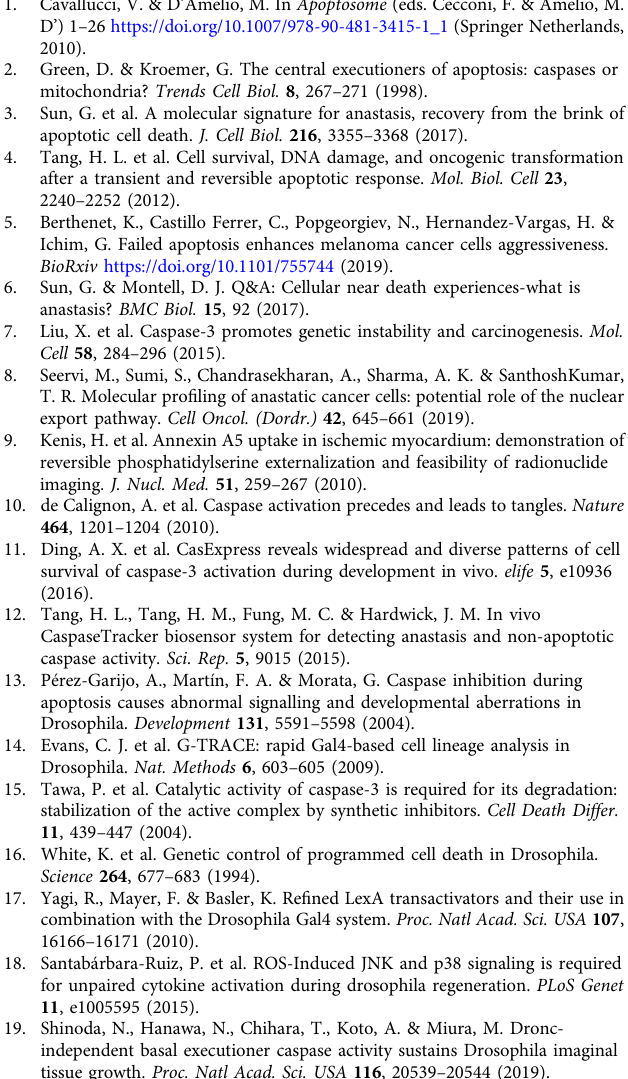
PAGE. The primary antibodies used in western blotting are listed in Supplemen- tary Table S3. The original scans of all blots were in Source Data fi le. Statistics and reproducibility . All the statistical analyses were done using Prism 6 software (GraphPad). Statistical signi fi cance was determined after logarithm transformation using unpaired two-tailed t-test for two-sample comparison or one- way ANOVA for multiple-sample comparison. The Tukey test was used to derive adjusted P -value for multiple comparisons. All experiments were independently repeated at least three times to ensure reproducibility, and the representative images are shown in the fi